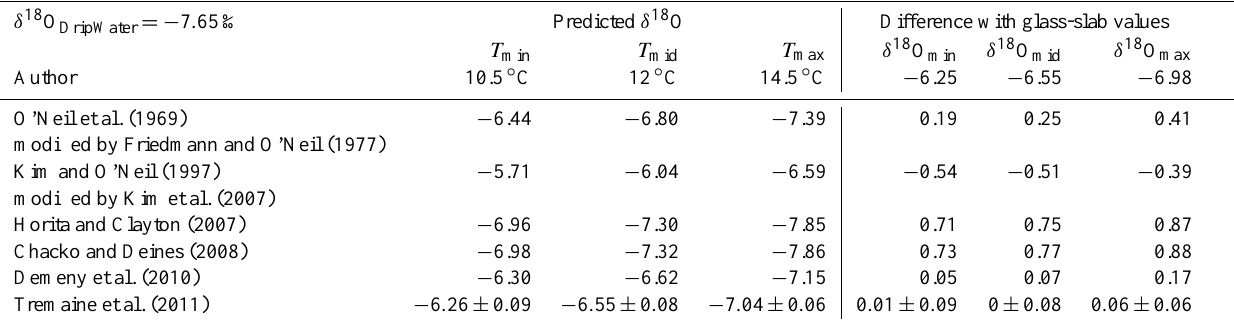
Table 2. Calculated δ 18 O values for calcite deposited in equilibrium with its drip water for different authors. Values were calculated using the average drip water composition of − 7.65‰ for the lowest, highest and average measured temperatures at the Salle-du-Dôme. The second part of the table shows the difference between the calculated δ 18 O values and the δ 18 O values measured on the glass slabs. Best results are given by the “in-cave” relationship of Tremaine et al.